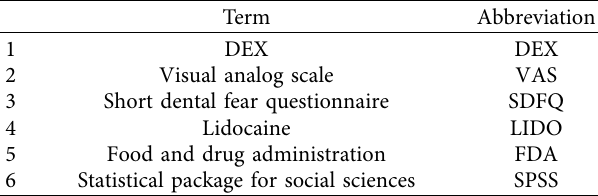
Table 1: Table of abbreviations for common